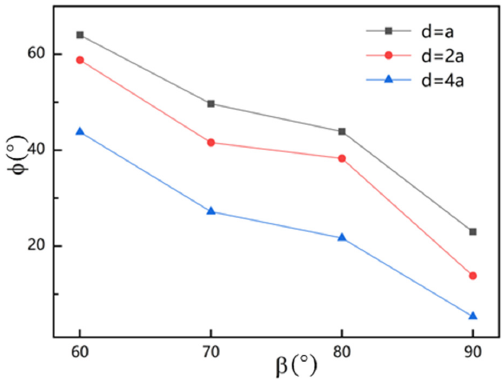
Figure 20. Effect of crack spacing and inclination angle on crack propagation.